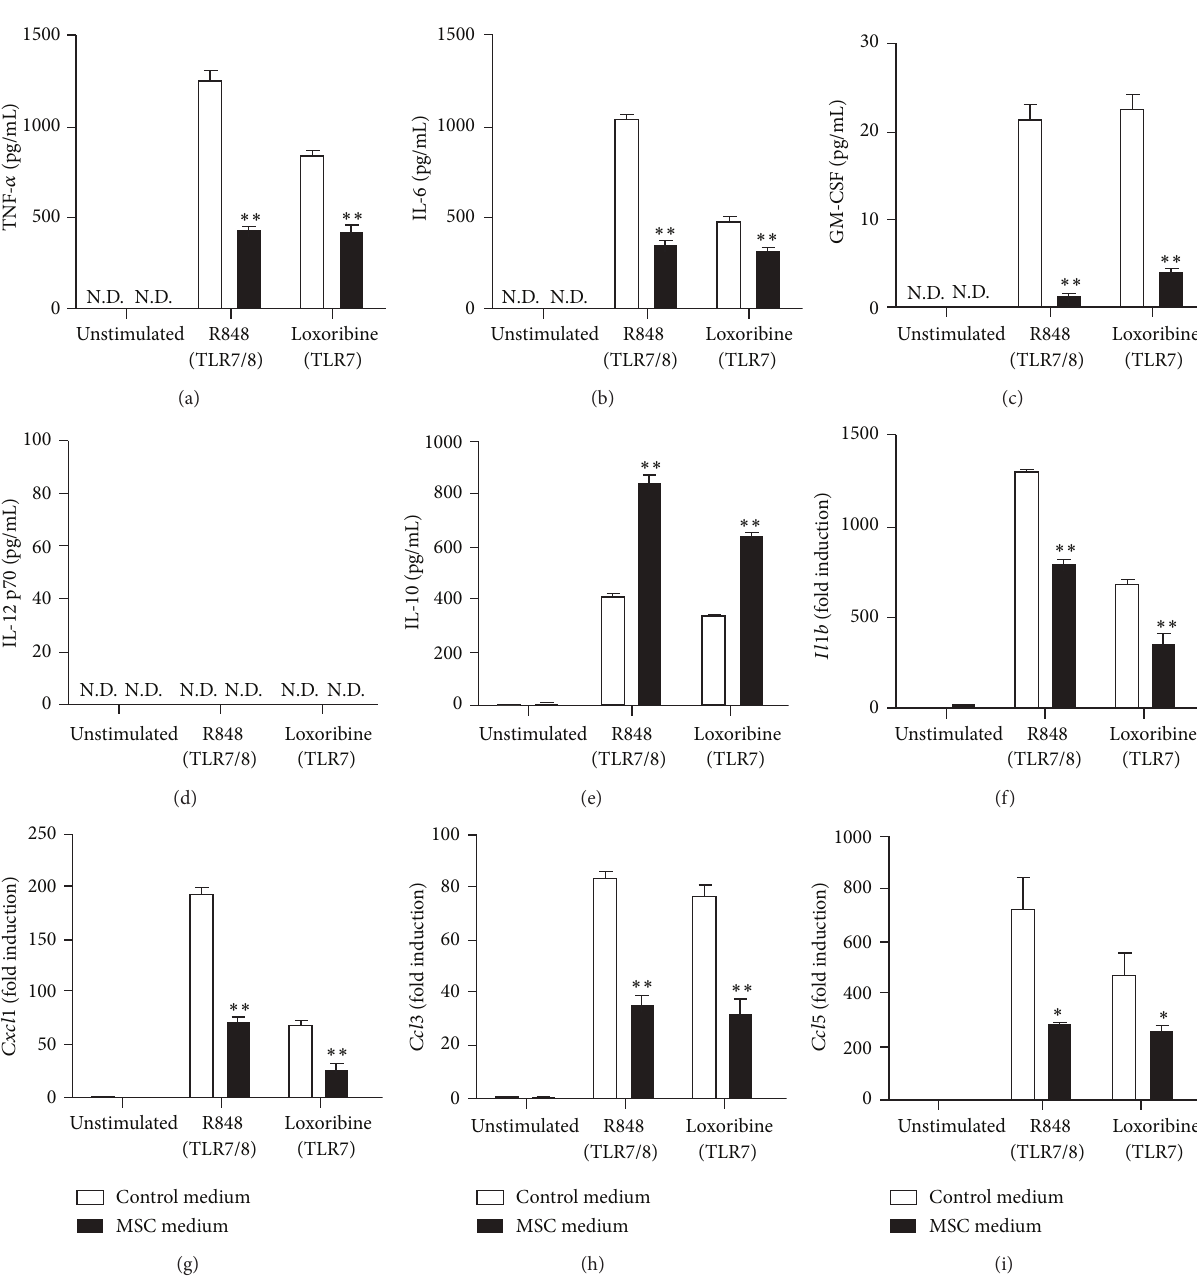
Figure 2: Modulation of cytokine expression by BMDMs incubated in MSC-conditioned medium and then stimulated with TLR7/8 ligands. BMDMswerepreincubatedfor1 hinMSC-conditionedmediumorcontrolmediumandthenincubatedwithR848(TLR7/8ligand,10 𝜇 g/mL) or loxoribine (TLR7 ligand, 300 𝜇 g/mL) for 24h. (a–e) The levels of murine TNF- 𝛼 (a), IL-6 (b), GM-CSF (c), IL-12 p70 (d), and IL-10 (e) in the culture supernatant were determined using ELISA. Data are expressed as the mean ± SEM. 𝑛 = 3 in each group. ∗ 𝑃 < 0.05 and ∗∗ 𝑃 < 0.01 , compared to the control medium group. N.D., not detected. (f–i) The levels of Il1b (f), Cxcl1 (g), Ccl3 (h), and Ccl5 (i) mRNA were determined using qRT-PCR. Data are expressed as fold increase over the level in the control medium group without TLR7/8 ligand stimulation (mean ± SEM). 𝑛 = 3 in each group. ∗ 𝑃 < 0.05 and ∗∗ 𝑃 < 0.01 , compared to the control medium group. Results are representative of 3-4 independent